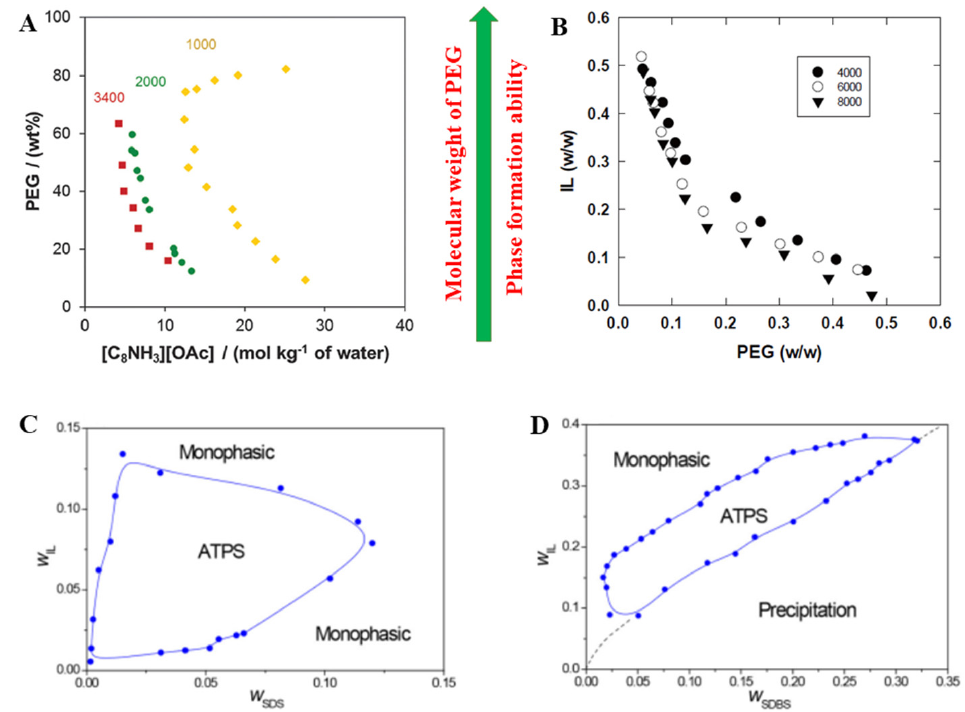
Figure 5. Effect of PEG molecular weight on phase formation ability of IL-based ATPS composed of [C 8 NH 3 ][OAc] + water + PEG ( A ) and [C 6 mim][C 12 SO 3 ] + water+ PEG ( B ) [84,133]; Phase diagrams (25 °C) of ternary systems of [C 2 pi][BF 4 ] + SDS + H 2 O ( C ) and [Phpi][BF 4 ] + SDBS + H 2 O ( D ) [134].